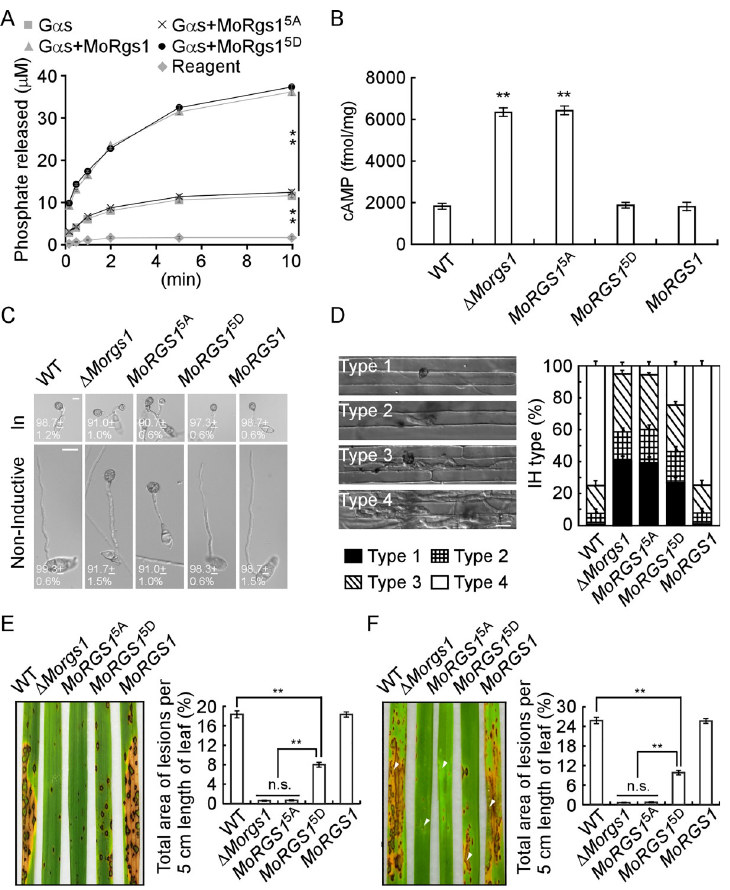
Fig 2. MoRgs1 phosphorylation is required for the appressorium formation and virulence of M . oryzae . (A) Measurement of MoRgs1 and its site-directed mutagenesis MoRgs1 5A and MoRgs1 5D accelerating the GTPase (released phosphate by time) rate of G α s in a single catalytic turnover at room temperature using the GTPase activity kit. Values are means of three replications and SD ( �� P < 0.01, n = 3). (B) Intracellular cAMP levels in mycelia of indicated strains cultured for 2 d in the complete medium (CM) and quantified by HPLC. Values are means of three replications and SD ( �� P < 0.01, n = 3). (C) Appressorium formation assay was conducted on non-inductive or inductive (In) surfaces. Conidia from the WT, Δ Morgs1 , MoRGS1 5A ( Δ Morgs1/MoRGS1 5A ), MoRGS1 5D ( Δ Morgs1/MoRGS1 5D ), and complemented MoRGS1 ( Δ Morgs1/MoRGS1 )strains were dropped onto corresponding surfaces and photographed by confocal microscopy at 24 h. Values are means of three replications and SD ( �� P < 0.01, n = 100). (D) Detailed observation with statistical analysis for infectious hyphal growth in rice sheath cells at 24 hpi. Four milliliters of conidial suspension (1 × 10 5 spores/ml) of each strain were used for the injection. Appressorium penetration sites were observed, and IH were rated from type 1 to type 4 (n = 100). Error bars represent SD from three independent replicates. (E) Rice spraying assays in vivo and lesion area statistics. Conidial suspensions (5 × 10 4 spores/ml) were sprayed onto 2-week-old rice seedlings (CO-39). Diseased rice leaves were photographed and the percentage of per 5 cm length leaf lesion area were analyzed by ImageJ after 7 days of inoculation ( �� P < 0.01, n = 10). Error bars represent SD from three independent replicates. (F) Rice sheath injecting assays in vivo and lesion area statistics. Conidial suspensions (2 × 10 5 spores/ml) were sprayed onto 4-week-old rice seedlings (CO-39). Diseased rice leaves were photographed, and the percentage of per 5 cm length leaf lesion area was analyzed by ImageJ after 5 days of inoculation ( �� P < 0.01, n = 10). Error bars represent SD from three independent replicates. White triangles point out the injection